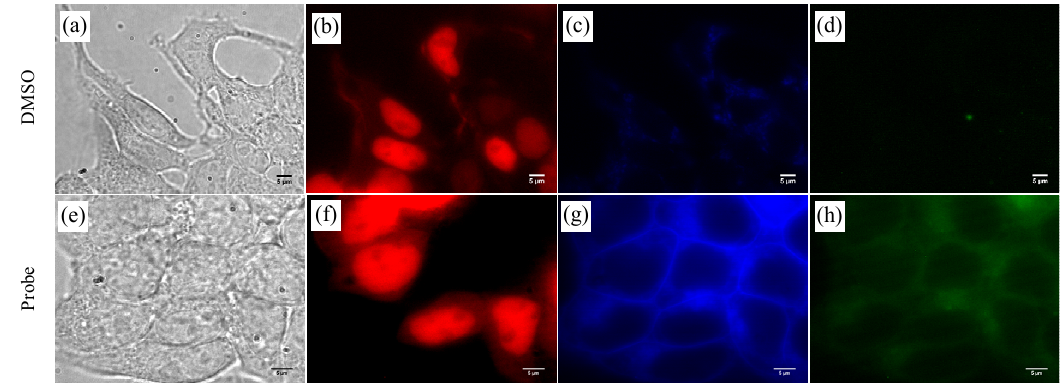
Fig. 9 Fluorescent microscope images of NLS-mCh. expressing HEK 293 cells treated with 0.5% DMSO [(a) – (d)] or 50  M ThiAKS Green [(e) – (h)] for 1.5 hours: (a) bright-field image, (b) mCh. channel, (c) DAPI Channel, (d) EGFP channel, (e) bright-field image, (f) mCh. channel, (g) DAPI channel, and (h) EGFP channel. (Magnification 100X, scale bars are 5